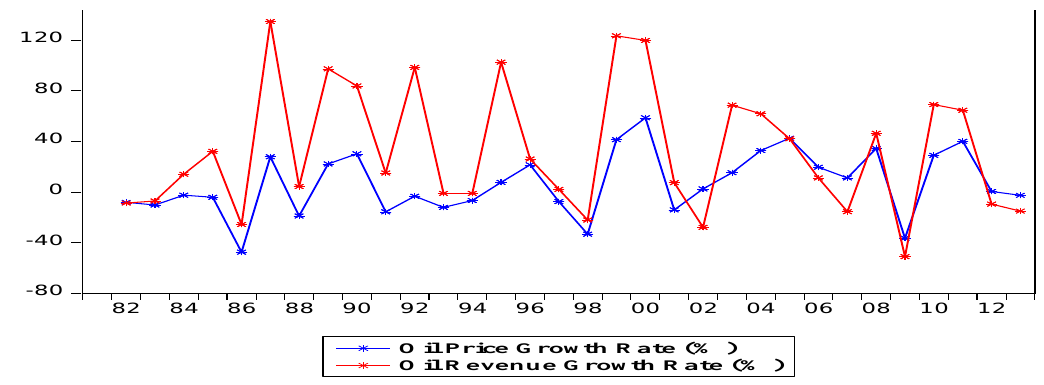
Figure 1 : Trend of oil price and oil-revenue growth rates